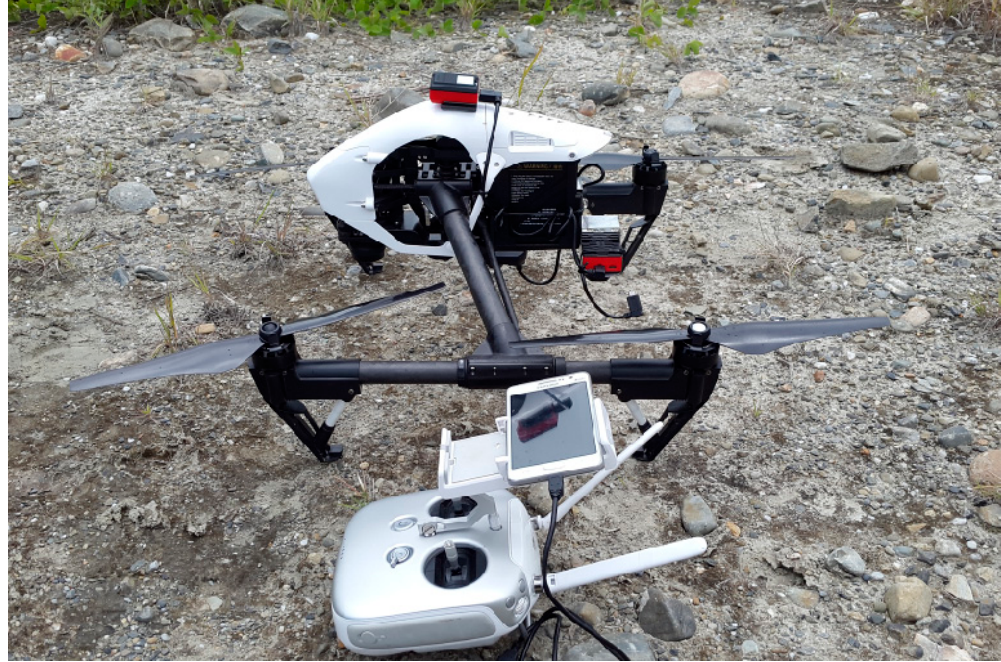
Figure 2. Unmanned aerial vehicle (UAV) DJI Inspire 1, equipped with the RGB camera ZENMUSE X3 and the multi-spectral camera Parrot Sequoia.